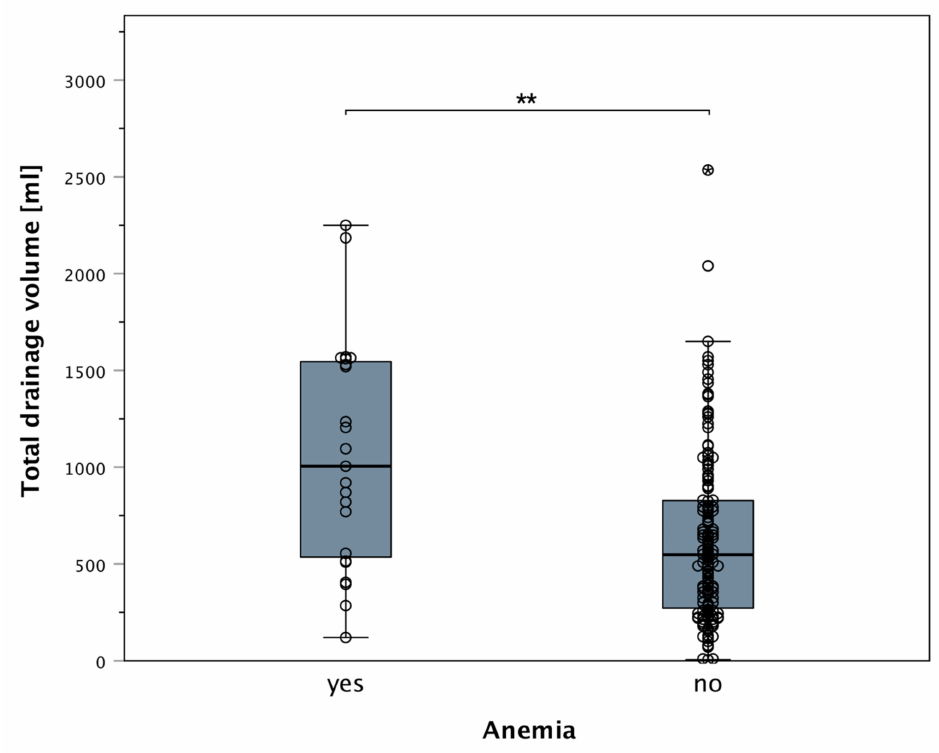
Figure 5. Boxplot of patients with preoperative anemia and drainage fluid volume: patients with preoperative anemia displayed significantly higher drainage output compared to preoperatively non-anemic patients (U = 2448.5; * p = 0.0012). The stars (**) indicate a statistically significant difference in preoperative anemic versus preoperative not anemic patients regarding postoperative total drainage volume ( p < 0.05). All data points (including outliers) can be seen as scattered dots overlying the